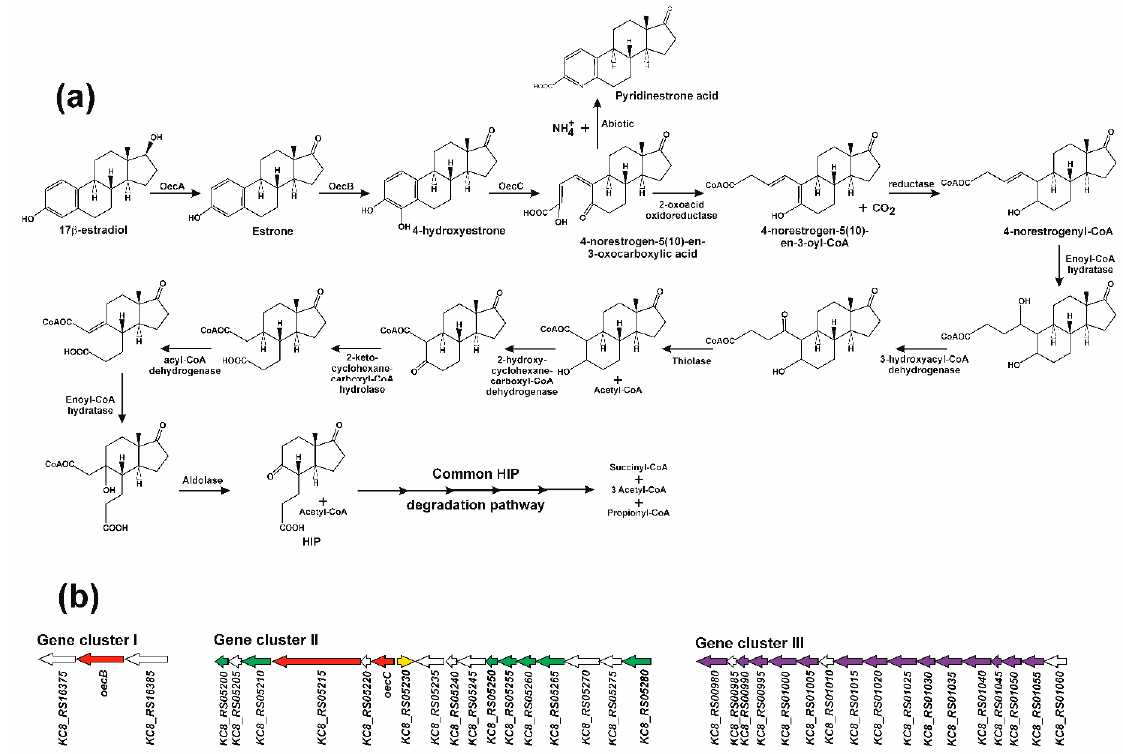
Figure 8. Metabolism of 17 β -estradiol in Sphingomonas sp. KC8. ( a ) Reactions of the 4,5- seco pathway. HIP, 3a α -H-4 α (3’-propanoate)7a- β -methylhexahydro-1,5-indanedione. ( b ) Genetic organisation of the